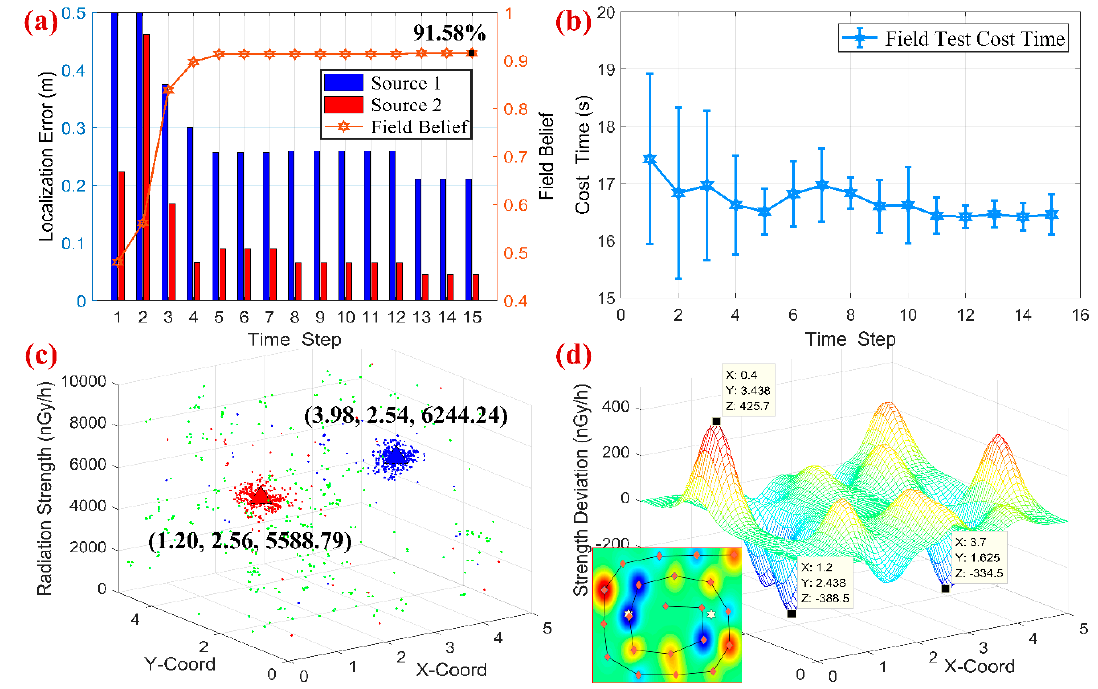
Figure 13. Quantitative analysis of field experiment. ( a ) the localization error and field belief w.r.t. time steps. ( b ) the cumulative cost time for each time step. ( c ) the final estimated clusters. ( d ) the regression surface of the measurements deviation.